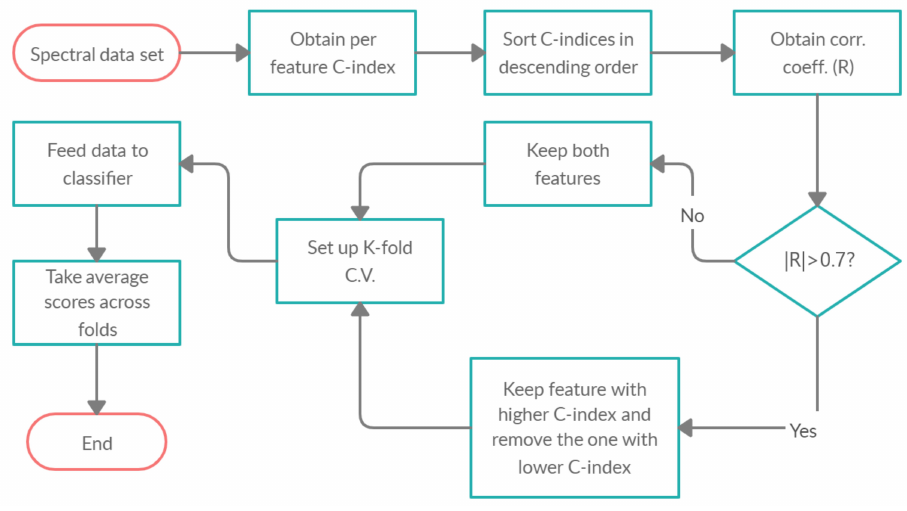
Figure 4. Flowchart of the algorithm used in this study. Table 2. Pod maturity classification data and the number of samples in for each sieve